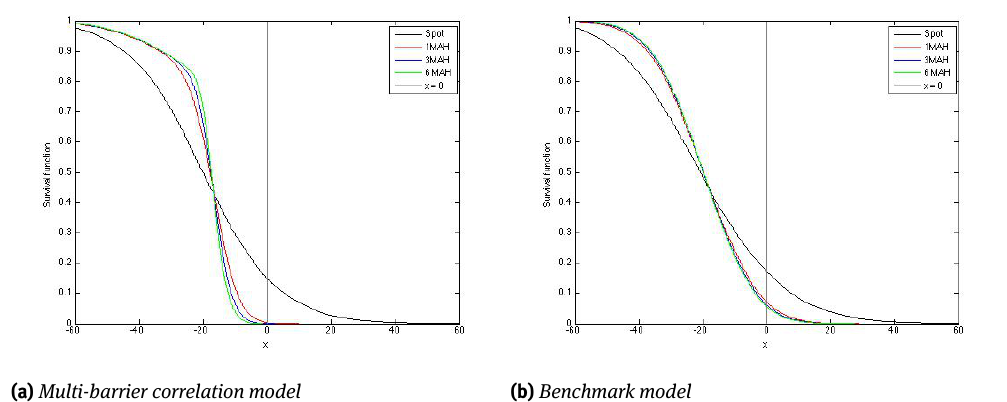
Figure 12: Empirical survival function of the difference between the price of electricity and the price of coal at time t = 335 days estimated with 10000 simulations with a time step of 1 24 days for different products (Spot, 1MAH, 3MAH, 6MAH) in the multi- barrier correlation model and in the benchmark model if the difference is equal to -20 at time t = 0